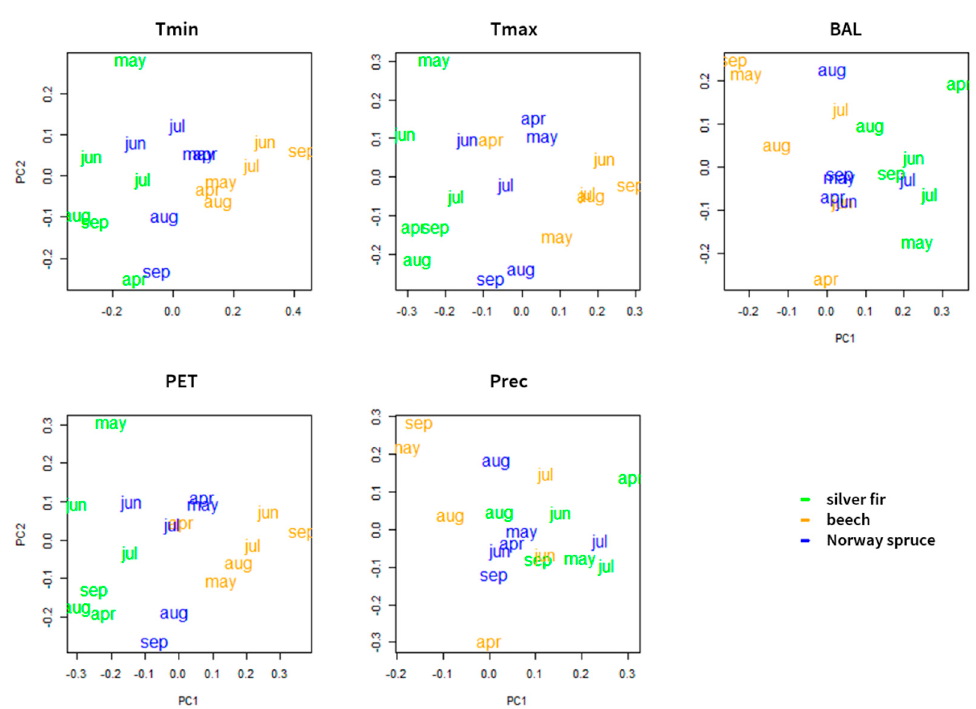
Figure 4. Saturation of the first and second components of the factorial analysis of beech, silver fir and Norway spruce moving correlations between tree ring growth and monthly climate variables (from April to September, respectively: Apr, May, Jun, Jul, Aug, Sep), here sorted by climate variable (i.e., Tmin, Tmax, BAL, PET, Prec).